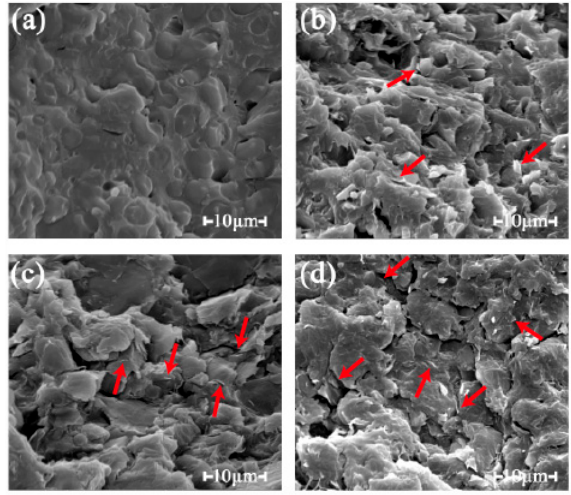
Figure 3. SEM micrographs of the fracture surfaces of composites with different rGO content: ( a ) 0 wt % rGO added in the composite, ( b ) 6 wt %, ( c ) 9 wt %, and ( d ) 12 wt %.